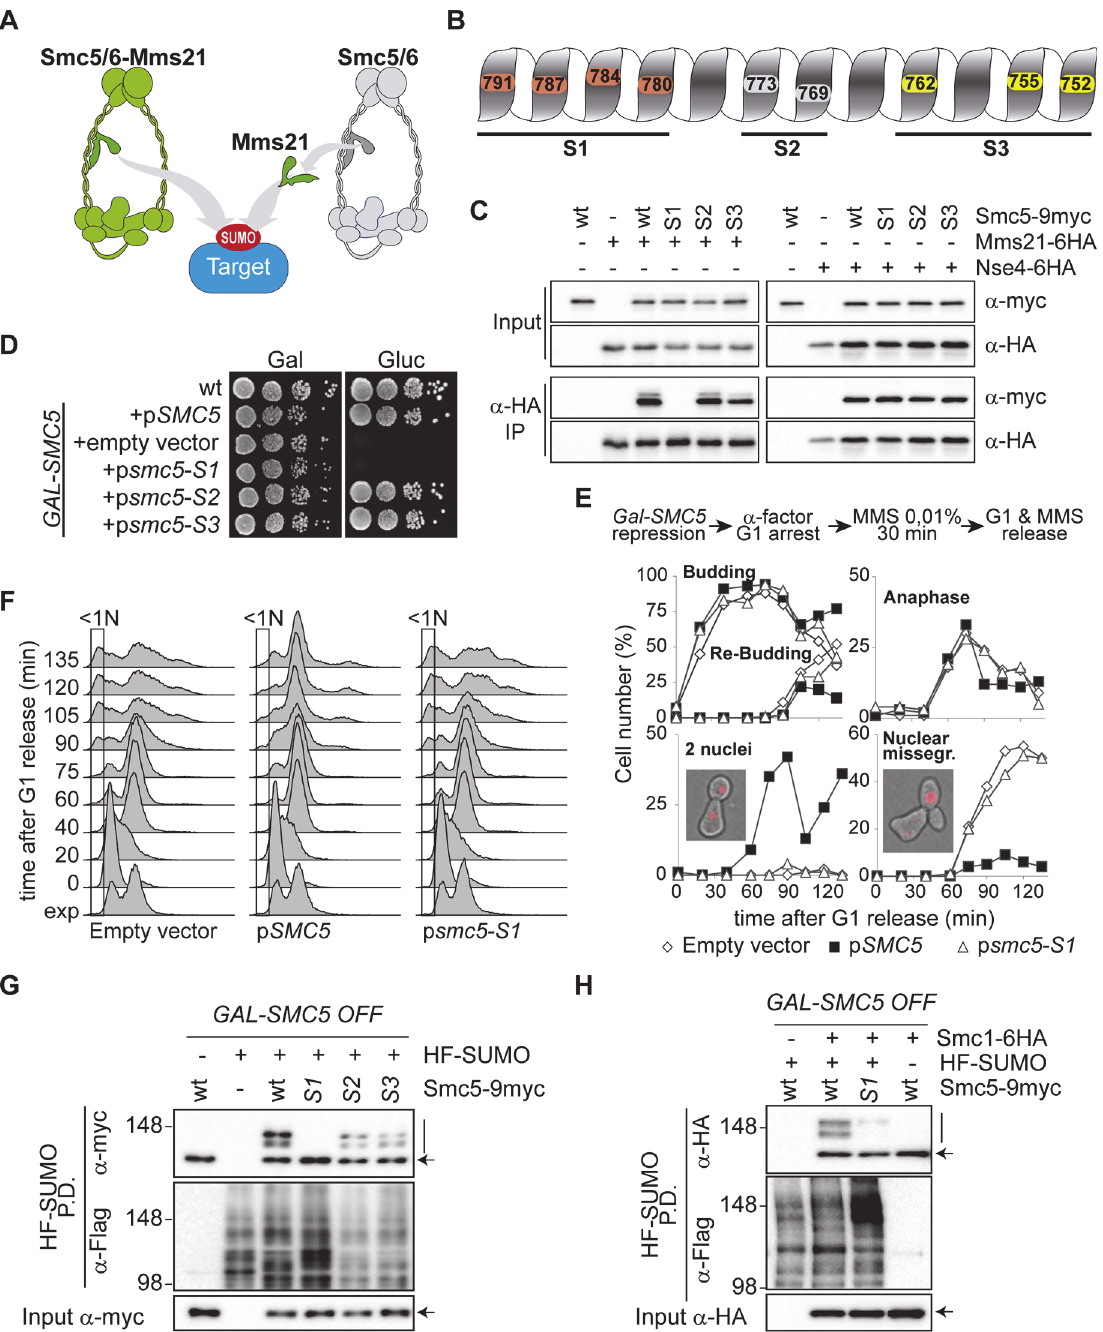
Fig 1. The Smc5-Mms21 interaction is required for sumoylation of Mms21 targets and chromosome segregation after DNA damage. A . Models for Mms21-dependent sumoylation: Mms21 may target proteins (including cohesin subunits) from its location in the Smc5/6 complex (left), or independently from Smc5/6 (right). B . Scheme of Mms21-binding surface on the coiled coil 2 of the Smc5 protein and location of mutated sites. C . Co-immunoprecipitation analysis of the Smc5-Mms21 and Smc5-Nse4 interactions. MMS21-6HA and NSE4-6HA cells were transformed with centromeric plasmids expressing the indicated SMC5 alleles and subjected to anti-HA immunoprecipitation. D . Growth test analysis of GALp-SMC5 cells transformed with the indicated centromeric plasmids. E and F . GALp-SMC5 cells bearing the indicated vectors were shifted to glucose for 4 h to repress expression of the endogenous SMC5 gene, and then treated as depicted in the figure; samples were taken at the indicated times for 4 ’ ,6-diamidino-2-phenylindole (DAPI) staining and microscopic examination (E) or Fluorescence-Activated Cell Sorting (FACS) analysis (F). Rectangles in F mark cells with less than 1N DNA content. G . GALp-SMC5 cells ectopically expressing the indicated SMC5 alleles from a centromeric vector were shifted to glucose for 6 h; 6xHis-Flag (HF) tagged SUMO was pulled down (P.D.) under denaturing conditions from yeast protein extracts (Input) to purify sumoylated species. Input and P.D. samples were